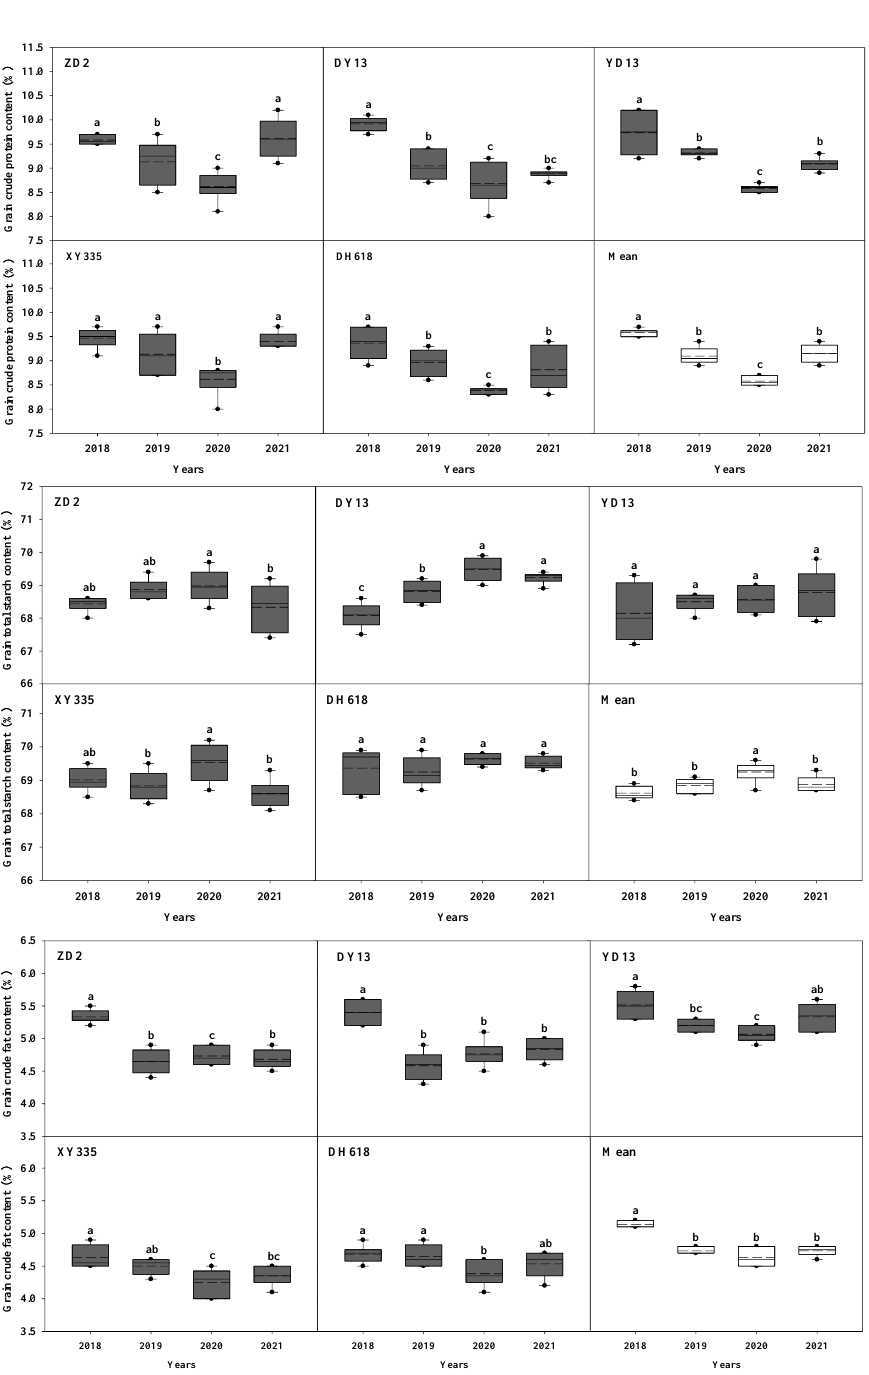
Commented [MDPI1]: Explanation latin letters, solid/empty.